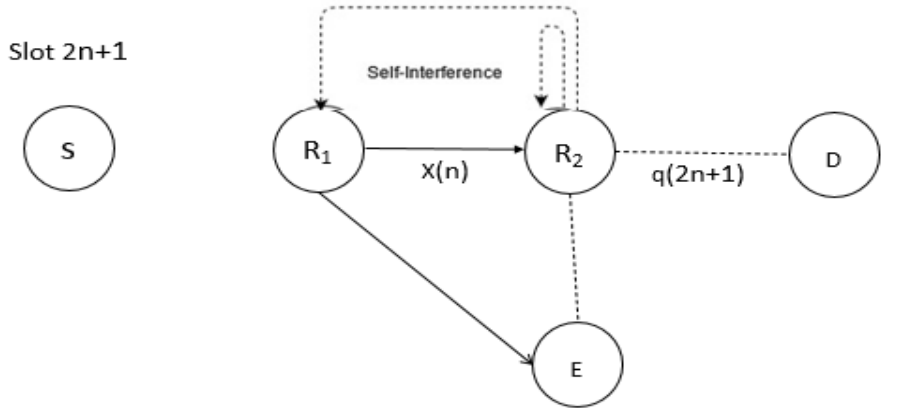
Figure 4. Transmission of signals in the 2( n + 1)th time slot.